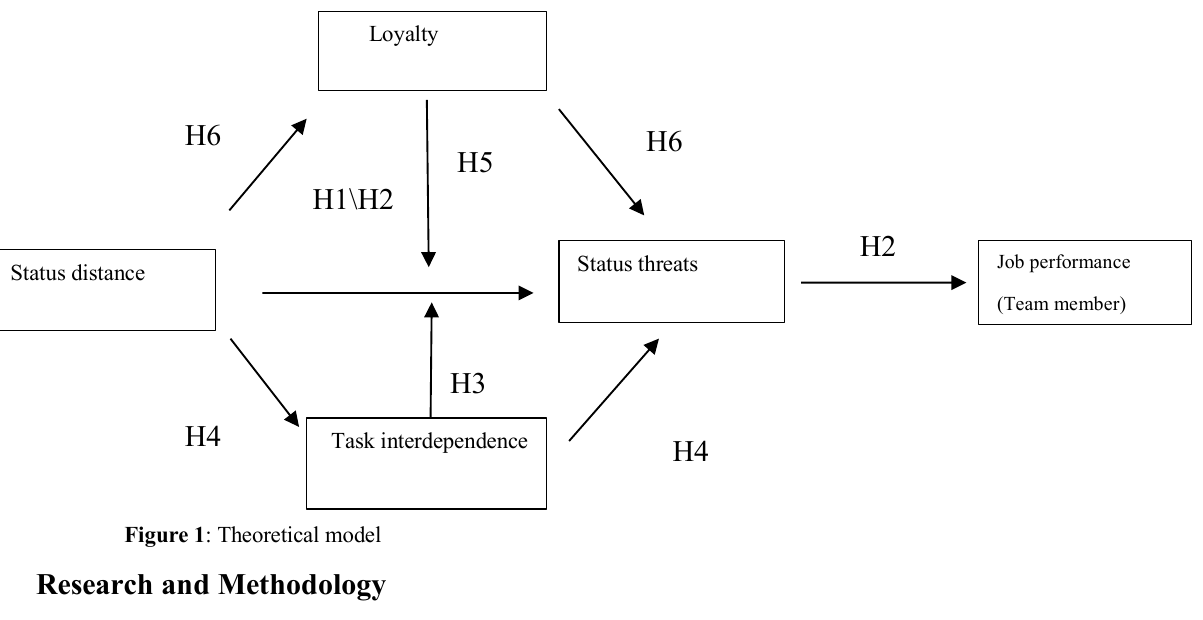
Figure 1 : Theoretical